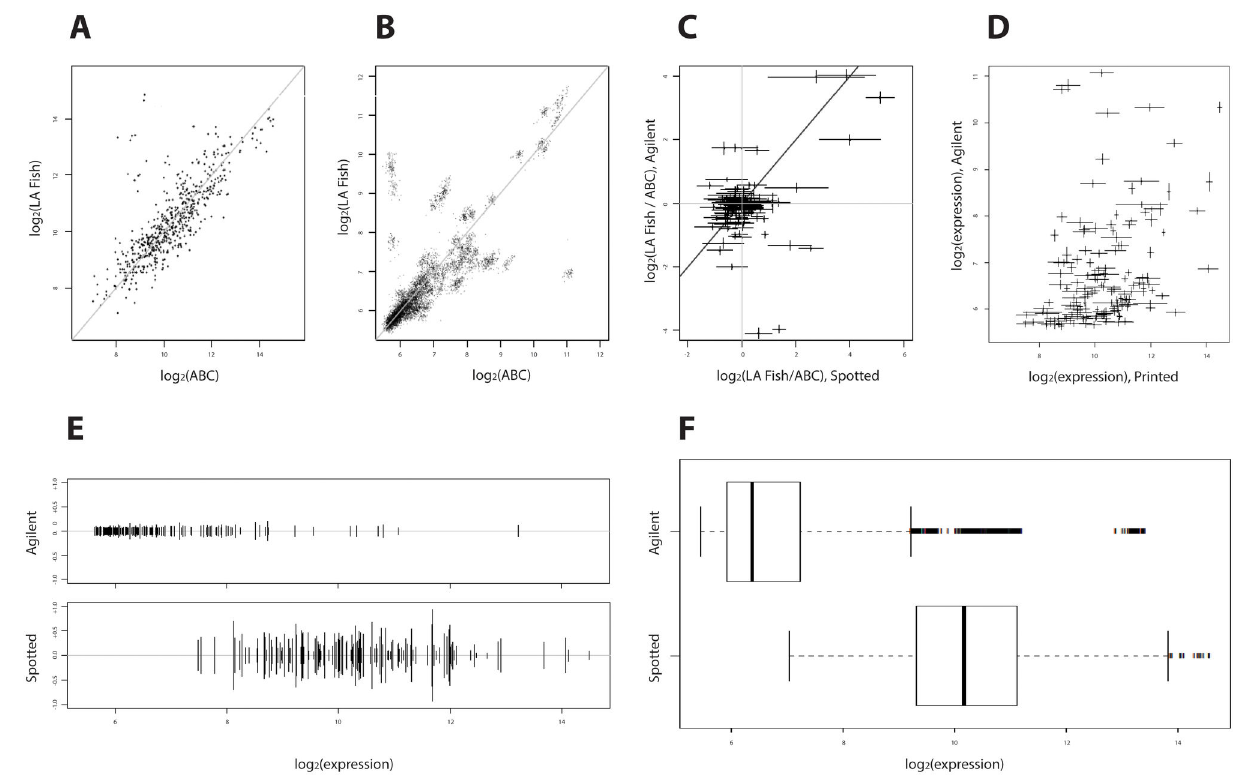
Figure 1. Quality control specifications for the second generation multi-species endocrine microarray. Comparison of the performance characteristics of on both prototype (spotted oligonucleotide) and second generation (Agilent ink jet oligonucleotide) endocrine multi-species microarray platforms; Panels A and B: scatter plots of log signal intensities of an individual fish from the 2 Los Angeles Sanitation District versus the control fish pool. Panels A and B depict prototype and second generation platforms respectively. Panel C; direct comparison of platform sensitivity defined as log ratio between treatment and ABC control. Panel D: 2 Analysis of signal concordance. Panel E: Analysis of variance with both platforms. To measure internal consistency (variance of internal replicates), log transformed expression value was plotted on the x-axis. Standard deviation is plotted on the y-axis, with a 2 range of plus or minus one standard deviation from the mean expression value. The y-axis is a measure of the deviation of individual replicate probes stray from the mean value. The second generation platform has smaller variance of the internal replicates. Probe variance on both platforms is independent of the signal. Panel F: Comparison of the probe signal intensity distribution (plotted as log transformed) for 149 probes that were present on both 2